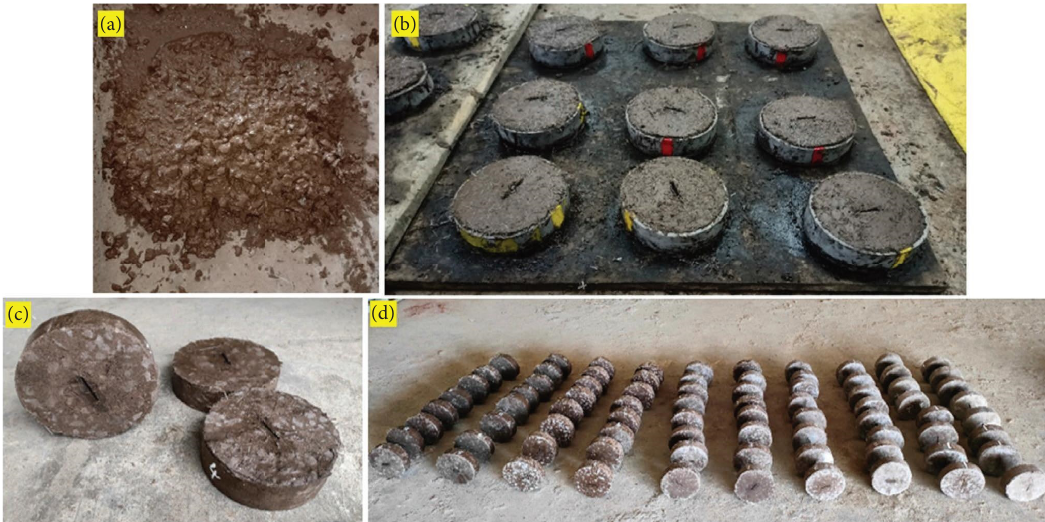
Figure 4: (a) Geopolymer mixture, (b) cast specimen with a notch, (c) demolded specimen, and (d) number of specimens before